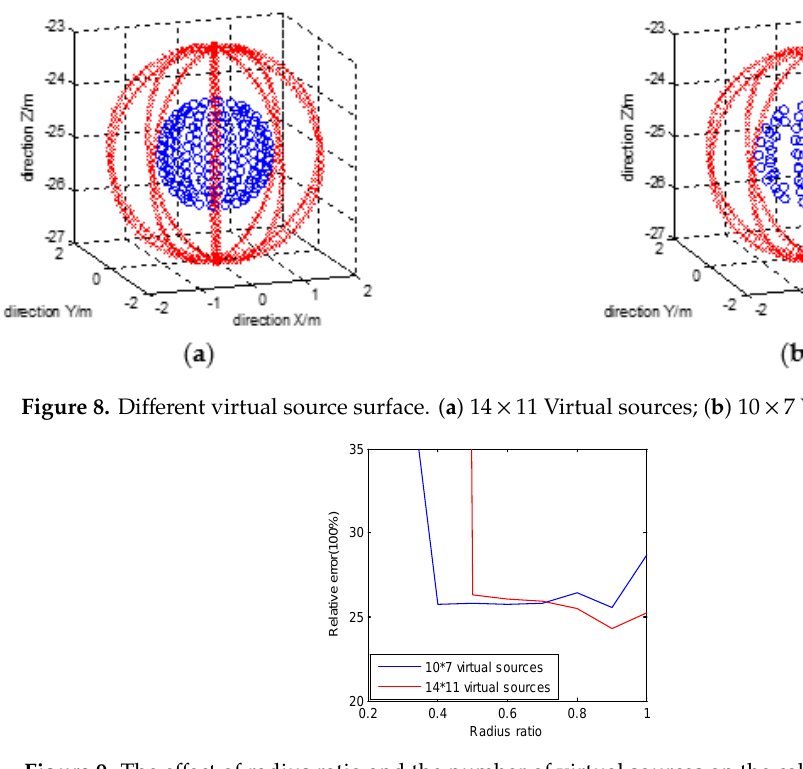
Figure 9. The effect of radius ratio and the number of virtual sources on the calculation result.